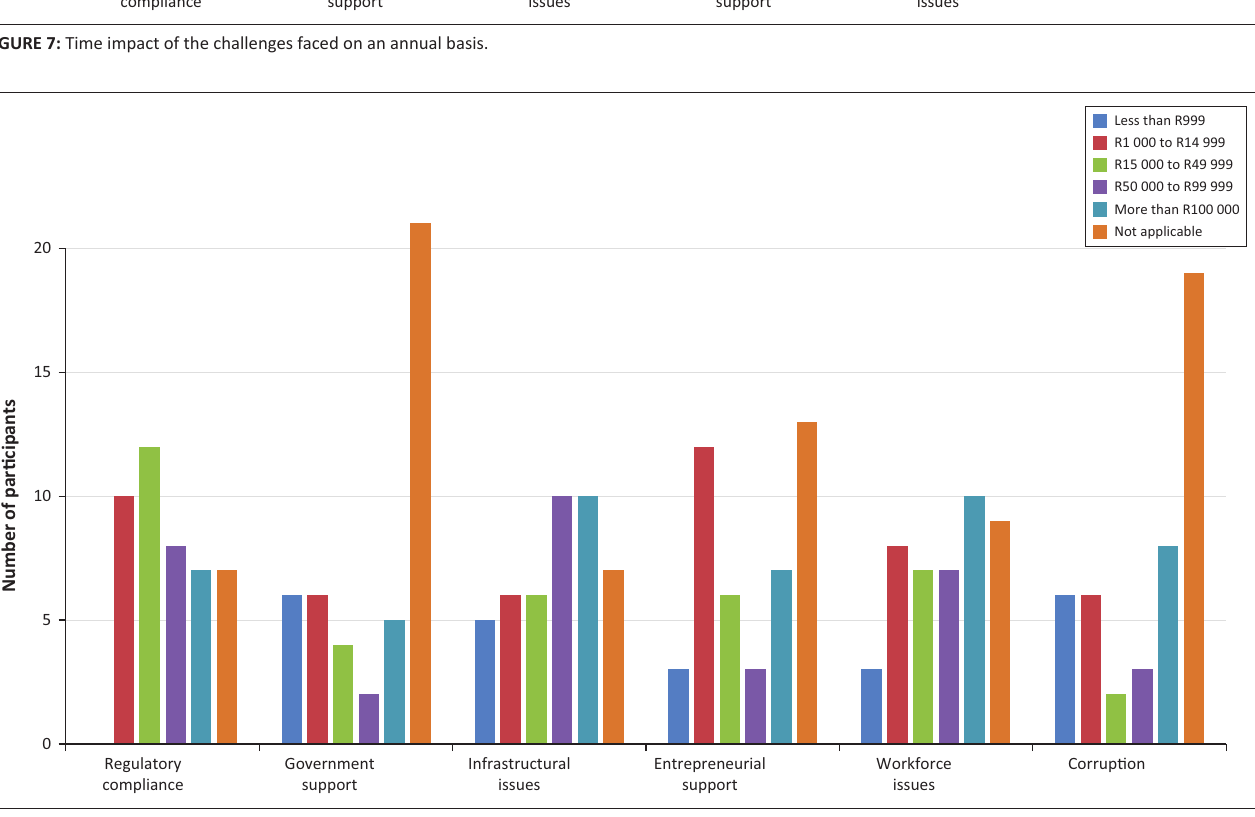
FIGURE 8: Annual cost impact because of challenges